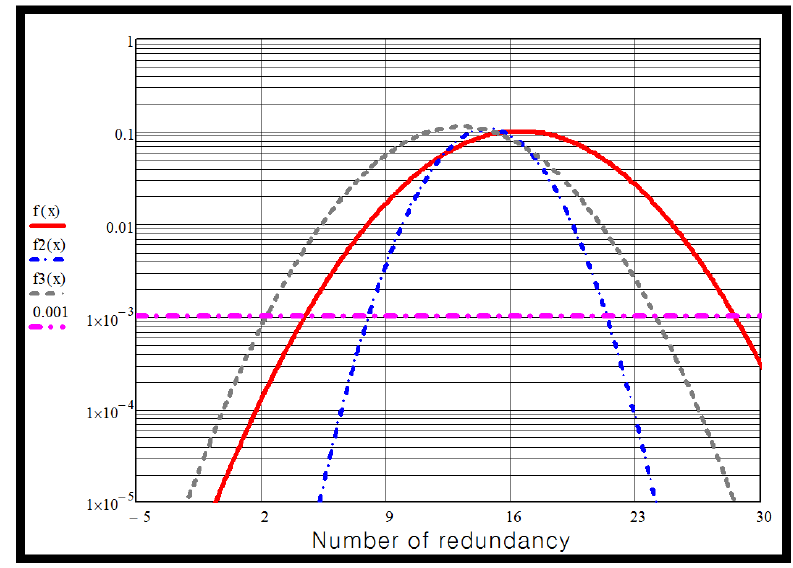
Figure 7. Unavailability function for MMC valve in case of 3-year